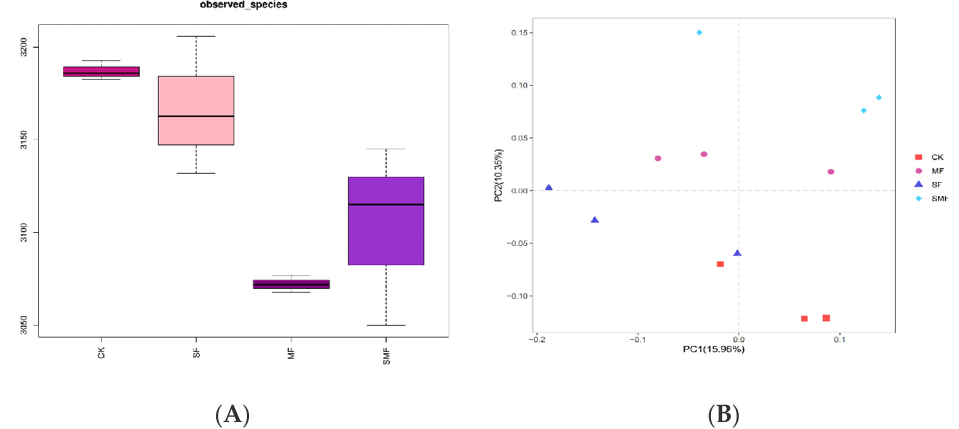
Figure 2. Bacterial diversity analysis of soil bacterial community treated by silicon fertilizer and microbial agents: ( A ): observed species ( p < 0.05); ( B ): principal coordinate analysis (PCoA).